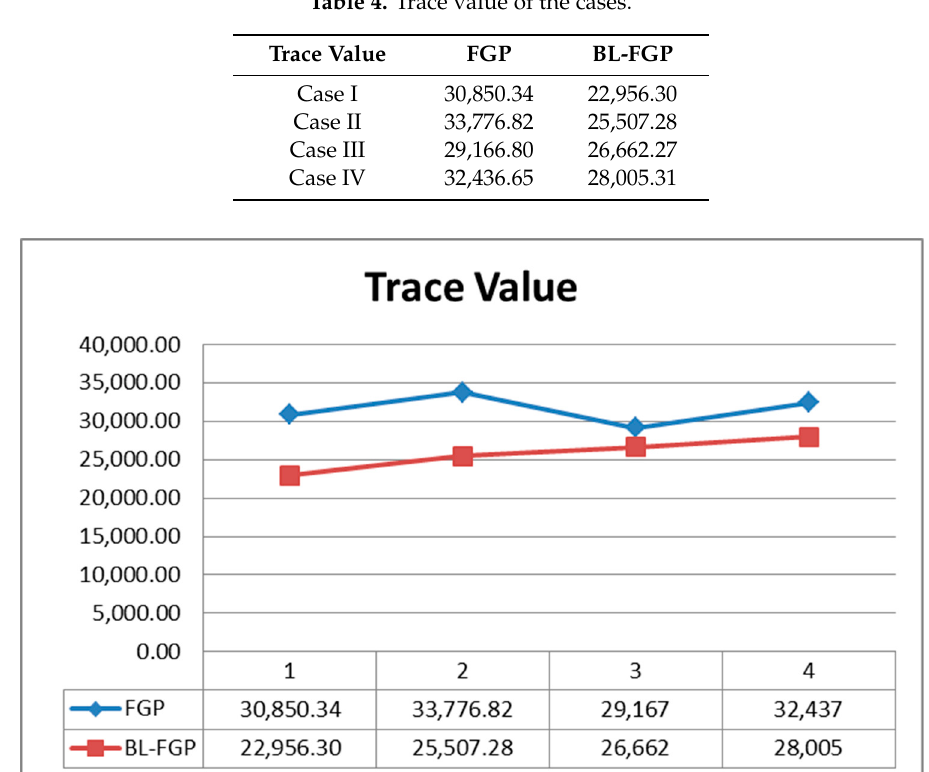
Figure 2. Trace value of different cases.